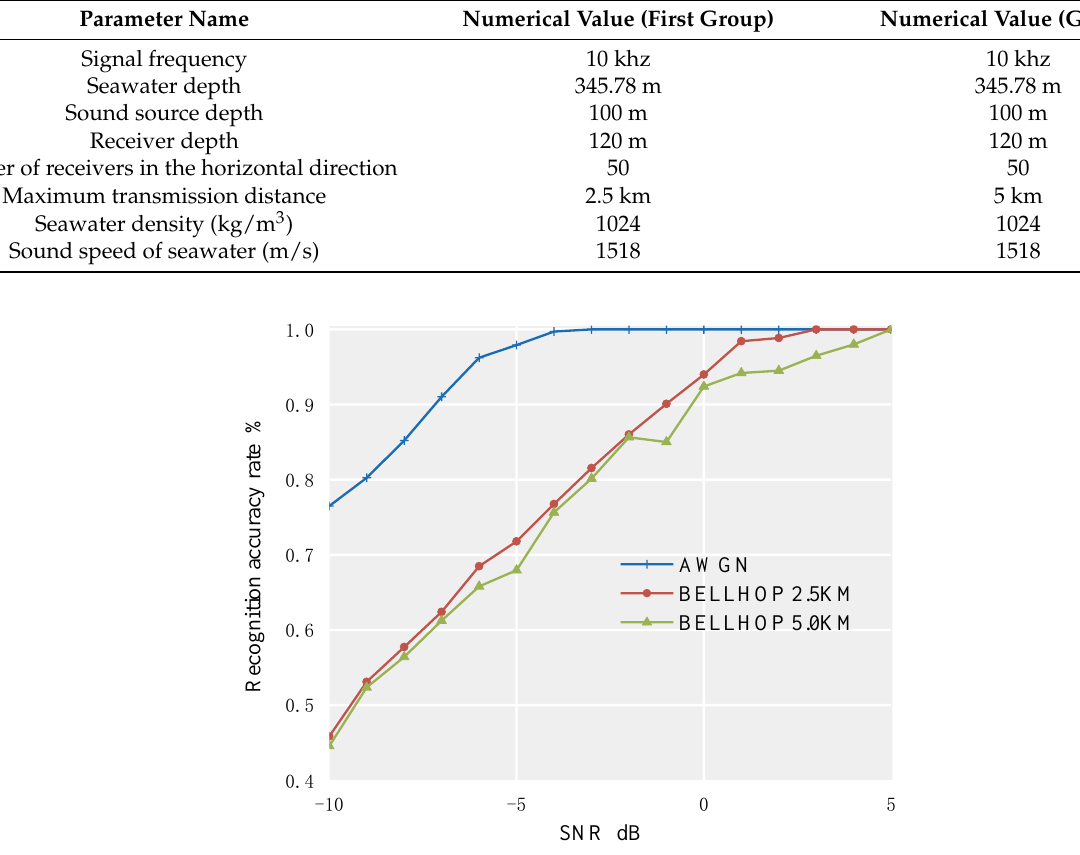
Figure 10. Comparison of recognition performance of AOA–RF algorithm in different channel environments.